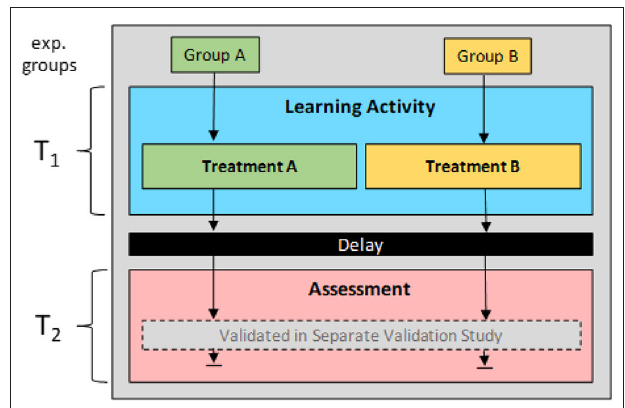
FIGURE 1 | Illustration of the conventional Single Treatment experimental design. Two experimental groups engage in contrasting learning activities, the outcomes of which are assessed in a common, externally validated assessment.